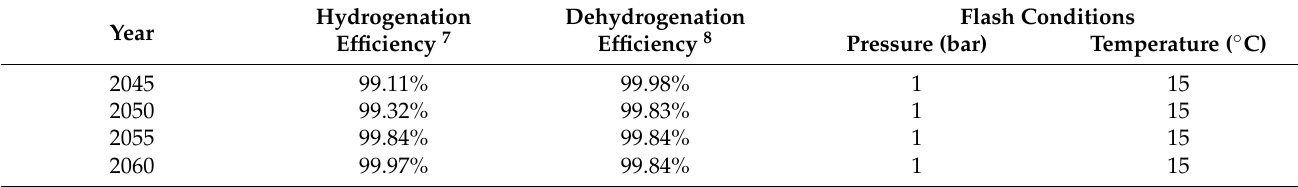
Table 11. LOHC (decalin-naphthalene system) hydrogen processes